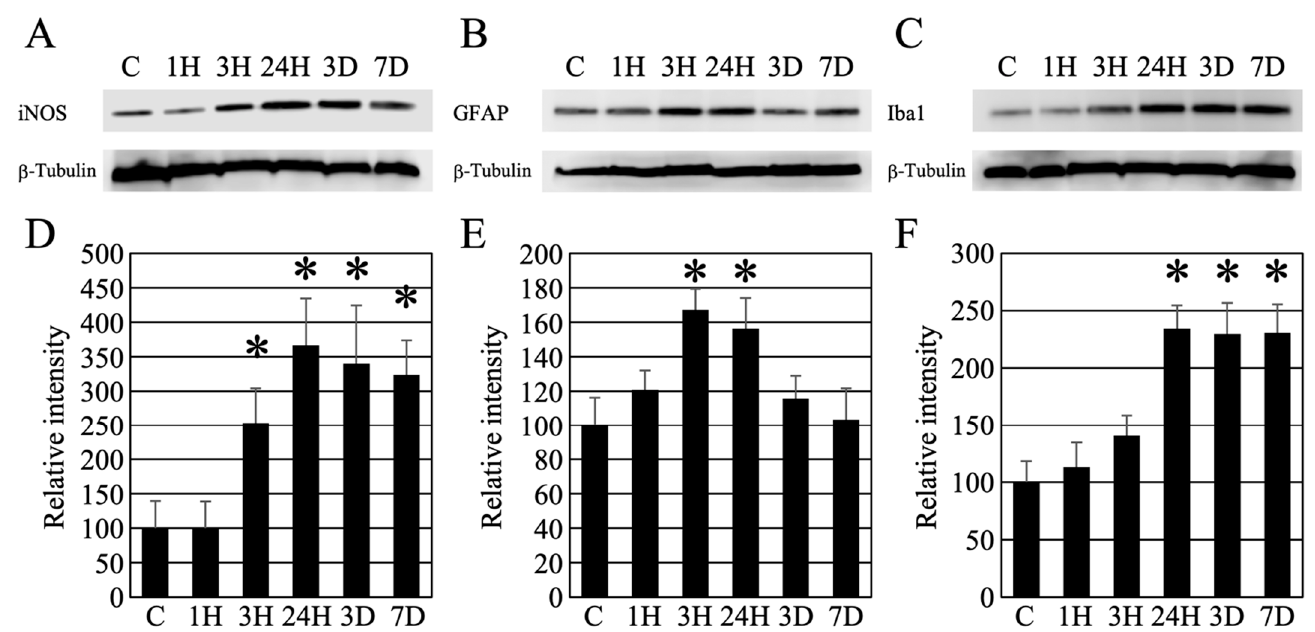
Figure 8. ( A – C ) Western blot analysis revealed the timing of iNOS, GFAP, and Iba1 expression following hepatic encephalopathy. In addition, as an internal control, the expression level of β -tubulin is presented. ( D – F ) Densitometry analysis of the Western blot data (each number = 5). Data are expressed as mean ± standard deviation. Data are shown as relative intensity (100 = the intensity of the control value). C, 1H, 3H, 24H, 3D, and 7D indicate the various treatment groups post-ammonia treatment (control, 1 h, 3 h, 24 h, 3 days, and 7 days), respectively. *: p < 0.05 compared with the control.